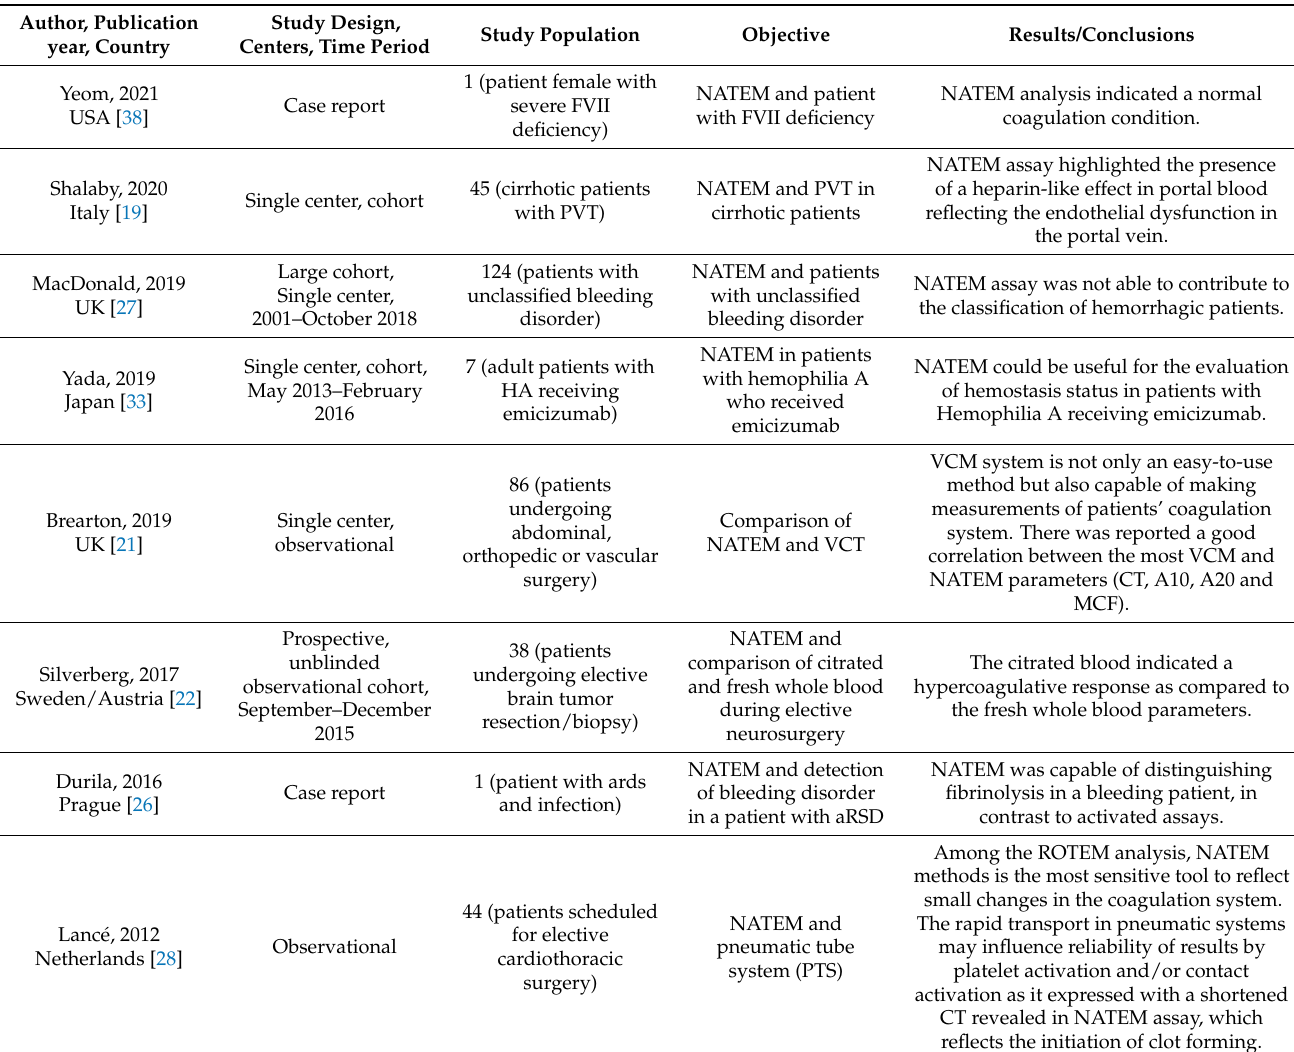
Table 4. NATEM assay application in different clinical